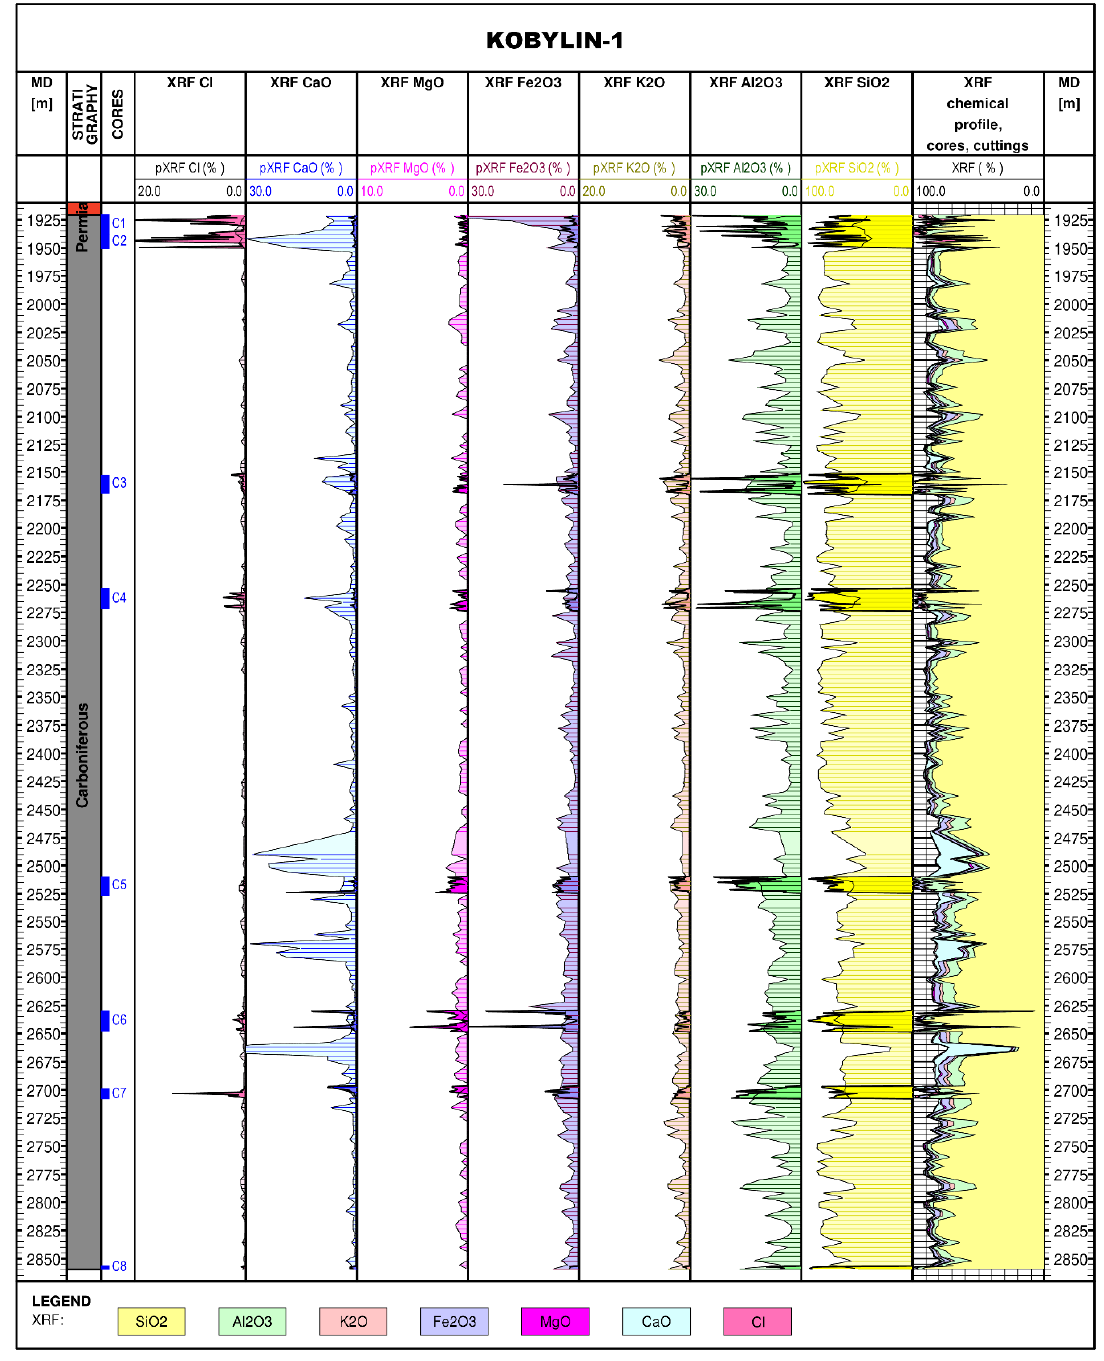
Figure 12. Table of results regarding XRF measurements taken on core samples and drill cuttings in the Kobylin-1 borehole. The darker colour marks cored intervals.